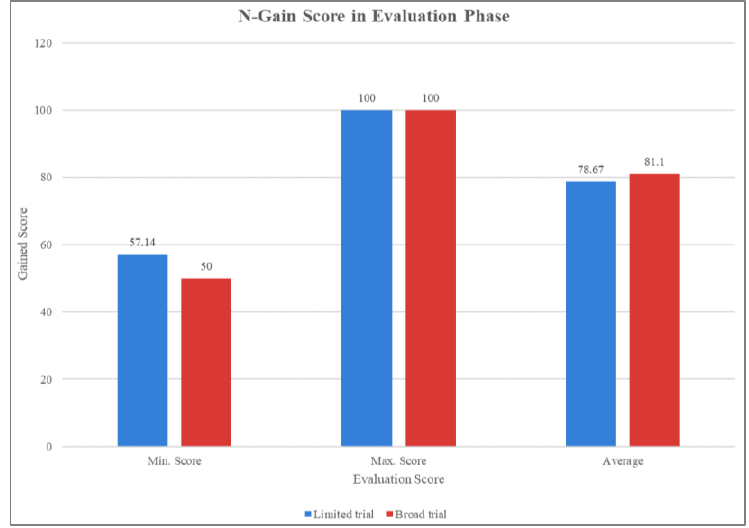
Figure 7. N-Gain score